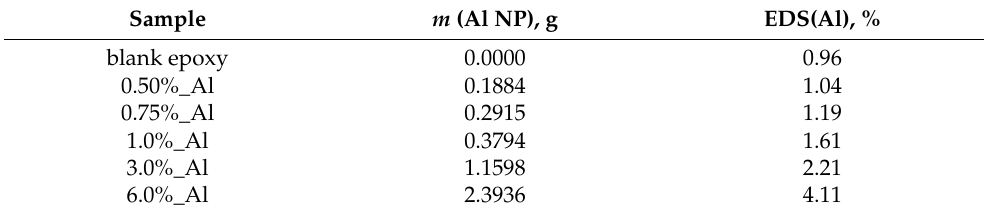
Table 2. Obtained chemical composition of aluminium in epoxy coating. Sample m (Al NP), g EDS(Al), % blank epoxy